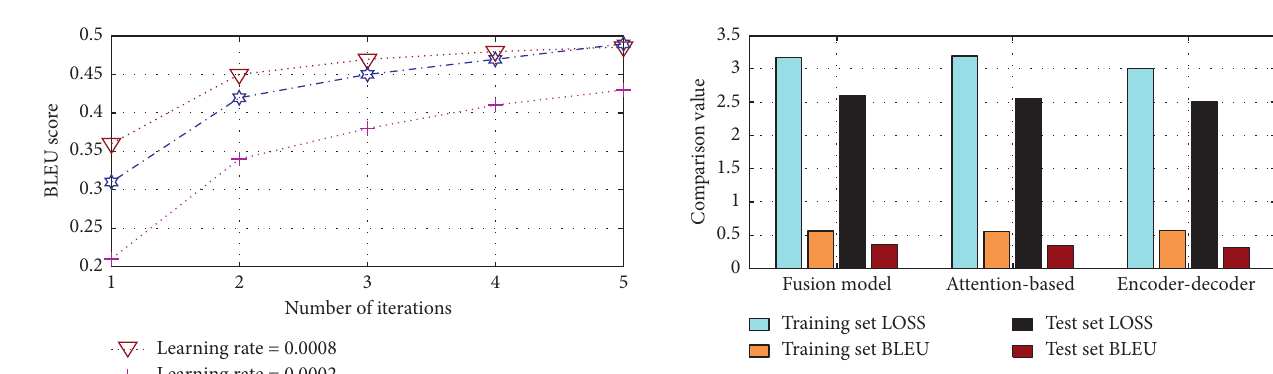
Figure 10: Comparison of experimental results of machine translation models.